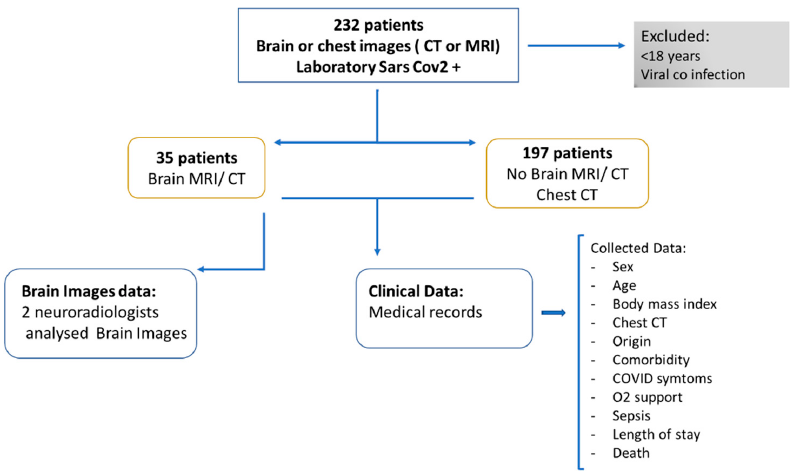
Figure 1. Block Diagram of the proposed research. The 232 confirmed COVID-19 patients were divided into two groups: (1) those who underwent a brain CT/MRI scan ( n = 35) and (2) those who did not undergo a brain